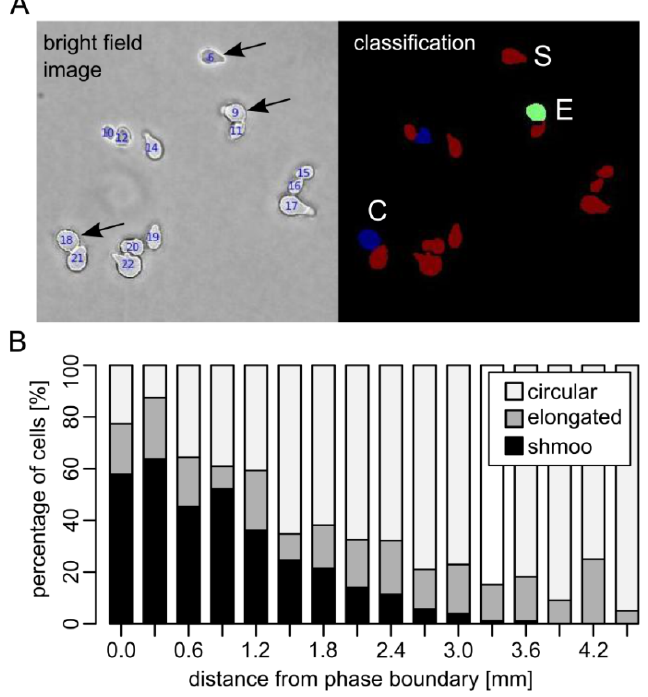
Figure 2. Spatial trend of mating projection formation of yeast cells exposed to diffusing α–factor. ( A ) Phenotype classification of yeast cells after α–factor treatment using ImageJ. Based on the shape property eccentricity E , cells were assigned to one of three classes; circular (C), elongated (E) or shmoo (S); ( B ) BY4741 bar1 Δ cells and 10 µM α–factor were immobilized in adjacent compartments. Proportions of cell phenotypes in different distances from the compartment boundary after six hours of incubation are